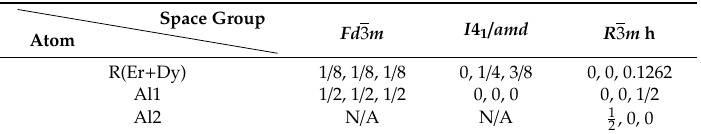
Figure 2. The Rietveld refinements of the powder X-ray di ff raction (PXRD) pattern of Er 0.9 Dy 0.1 Al 2 measured at 10 K using: ( a ) rhombohedral (R p = 8.4%, R B = 3.2%) and ( b ) cubic (R p = 8.7%, R B = 3.1%) models. Table 2. Coordinates of atoms in the unit cells of Er x Dy 1 − x Al 2 compounds. The hexagonal setting is adopted for the R 3 m rhombohedral symmetry.